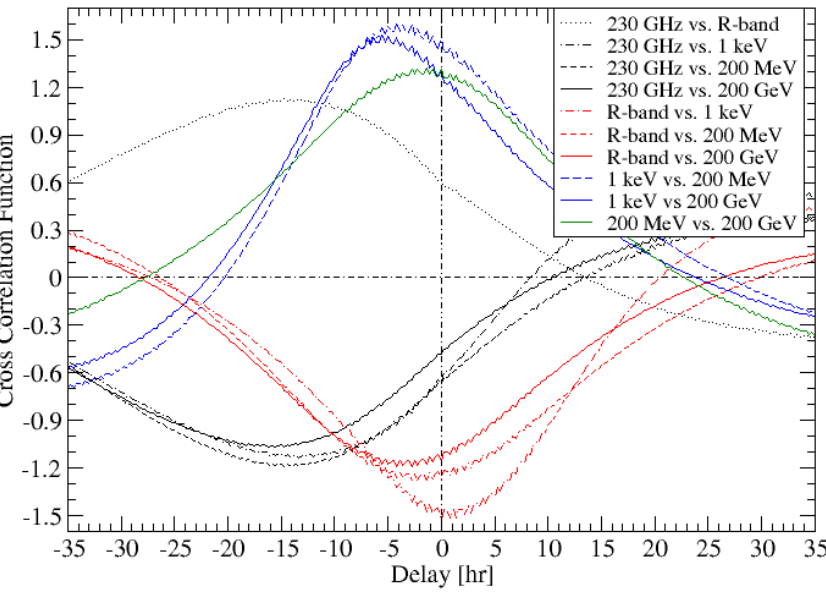
Figure 3. Cross-correlation functions between the model light curves in various energy/frequency